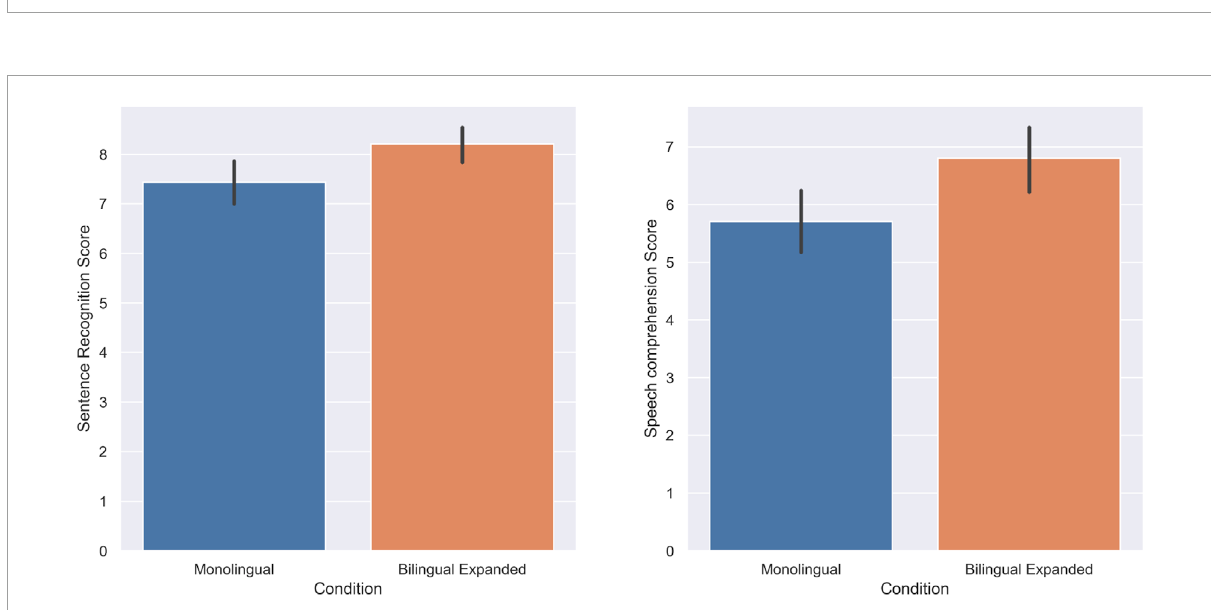
FIGURE 5 Experiment 3: Standard Monolingual and Expanded Bilingual. The score of subjects in the sentence recognition (A) and Speech comprehension (B) task.